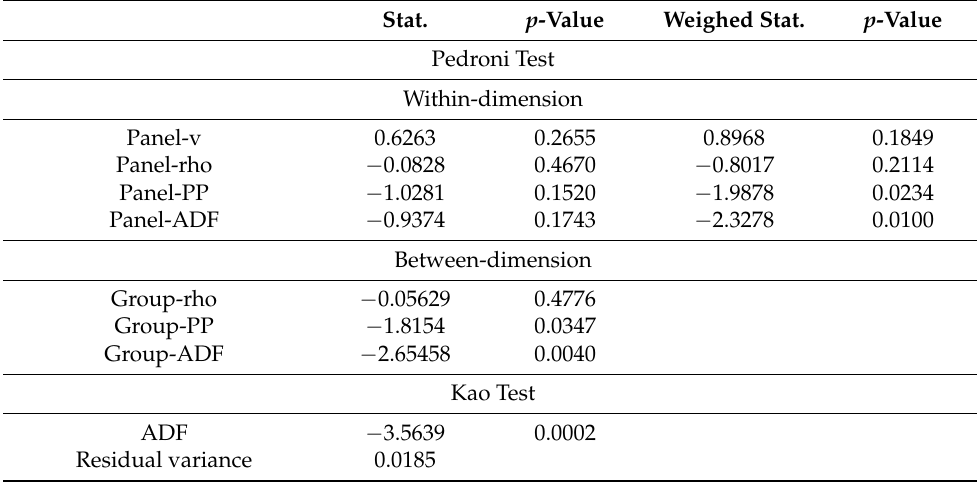
Table A2. Panel cointegration: LOC it as the dependent variable.